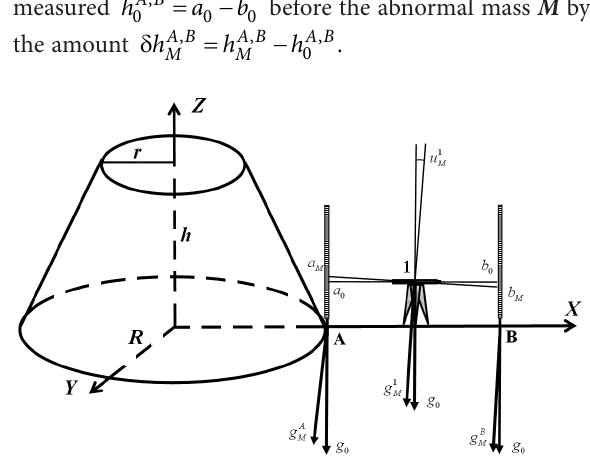
Figure 4. The first station leveling Procedure and results of the numerical experiment are presented as follows: For a truncated cone with the geometrical